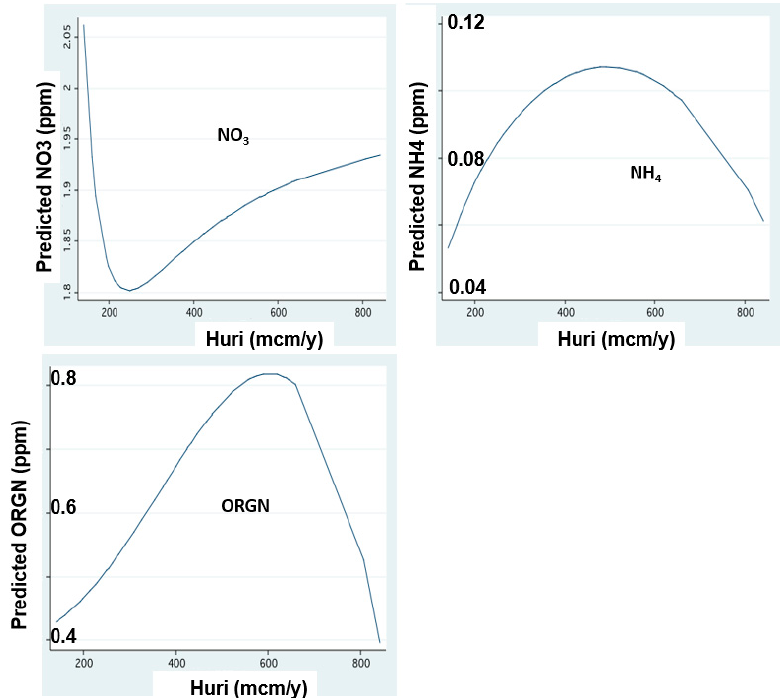
Figure 7. Nitrogen form concentrations in relation to Jordan discharge:FP regression between annual (1970–2018) mean concentrations (ppm) of Nitrate (NO 3 ), Ammonium (NH 4 ) and Organic Nitriogen (ORGN) in Jordan waters and annual Jordan discharge (mcm/y).